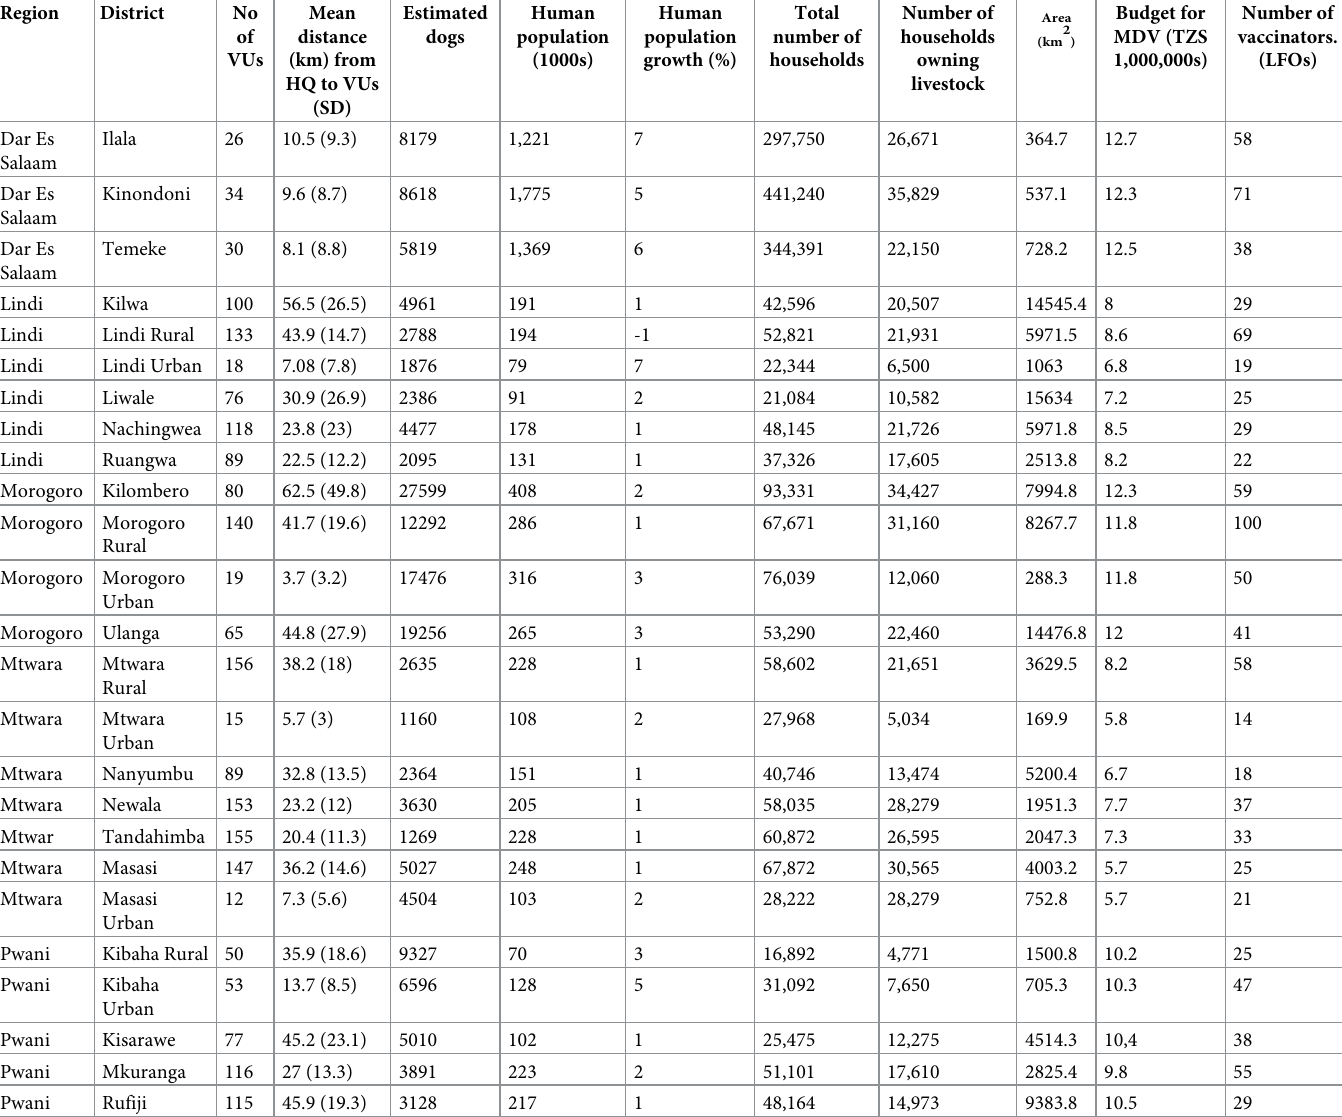
Table 1. Characteristics of the study districts where mass dog vaccinations and post-vaccination transects were conducted between 2010 and 2017. Region